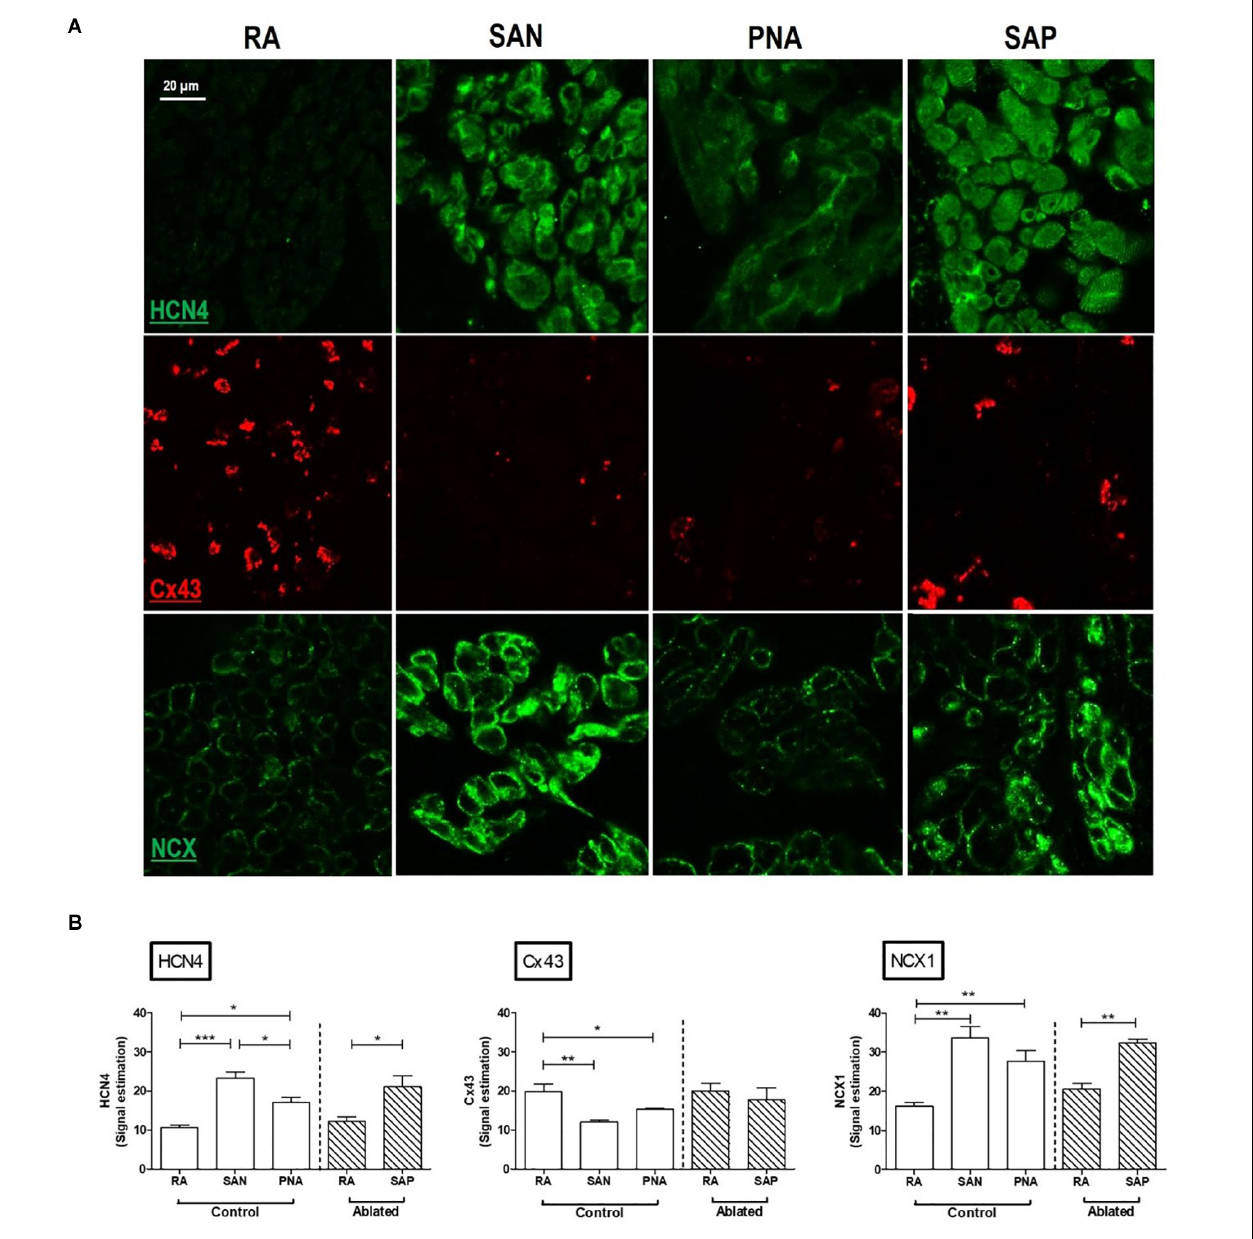
FIGURE 2 | Immunofluorescence comparison of the right atrium with the pacemaker regions. SAN, sinus node; PNA, paranodal area; SAP, subsidiary atrial pacemaker. (A) Immunofluorescence (IF) signal is shown for HCN4 protein in green (top rows), Cx43 protein in red (middle rows), and NCX1 protein in green (bottom rows). Sections were taken from RA, SAN, PNA, and SAP. (B) Semi-quantification of immunofluorescence signal intensities is shown, allowing comparison among RA, SAN, and PNA in control animals and the RA and SAP (leading pacemaker after ablation) in ablated animals * p < 0.05, ** p < 0.01, and *** p <